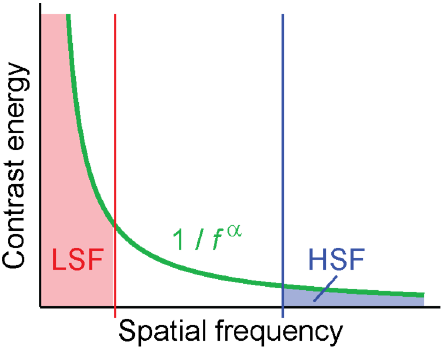
Figure 1. The 1/ f α distribution of contrast in natural images leads to much higher overall contrast in LSF-filtered images (red) than HSF-filtered images (blue).